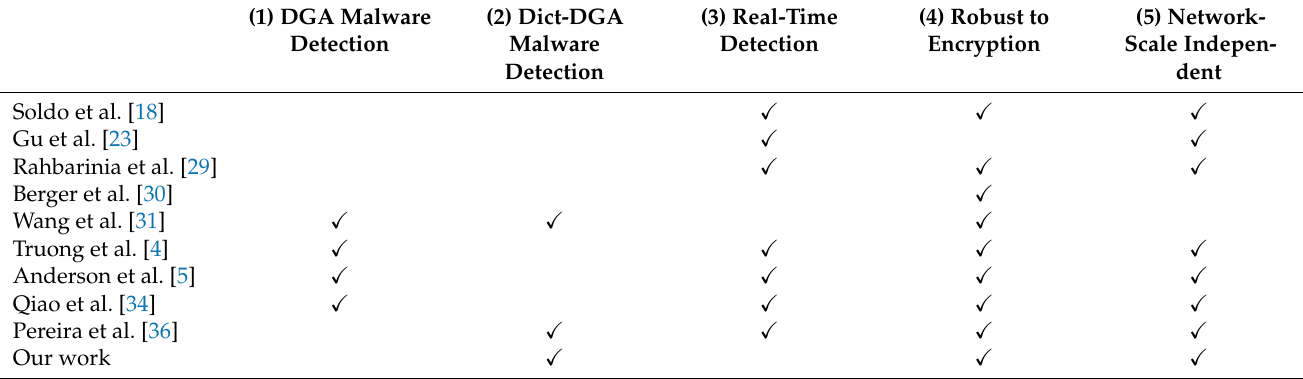
Table 7. Qualitative comparison of our work with other well-known detection methods. (1) DGA